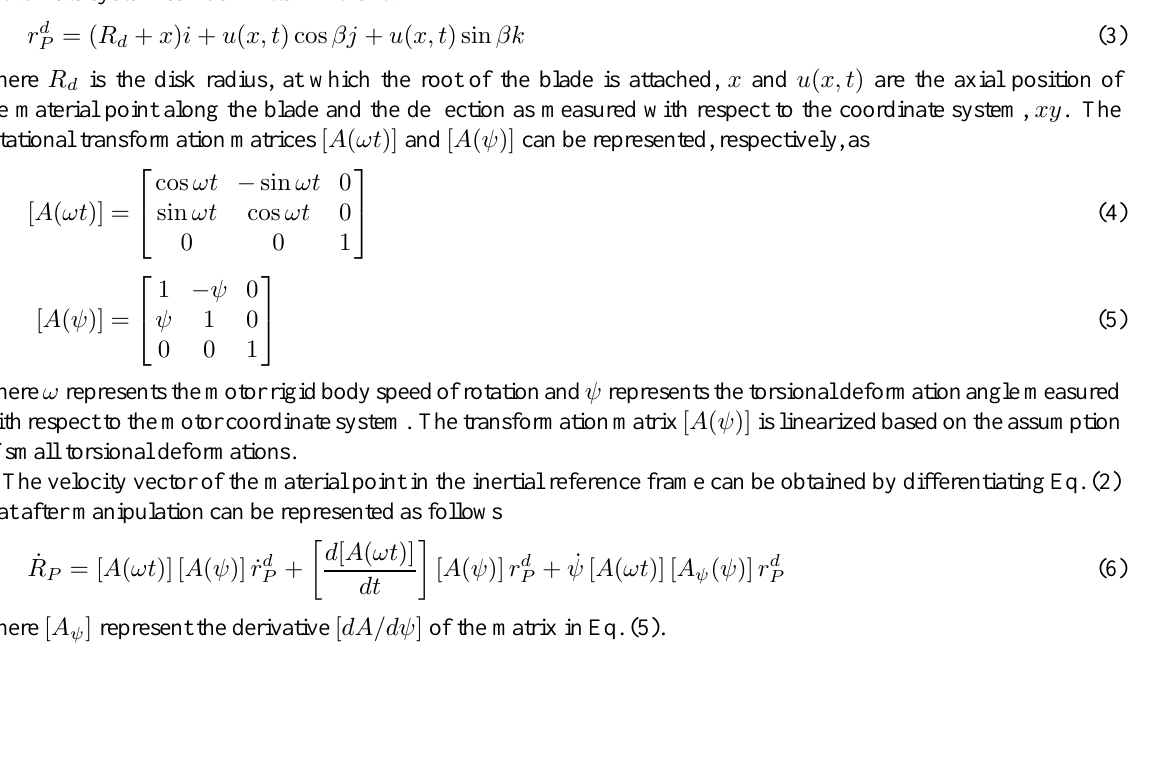
Fig. 2. Natural Frequencies as function of shaft torsional stiffness k T for setting angles: β = 0 ◦ , 30 ◦ , 60 ◦ , 90 ◦ . coordinate system can be written in the